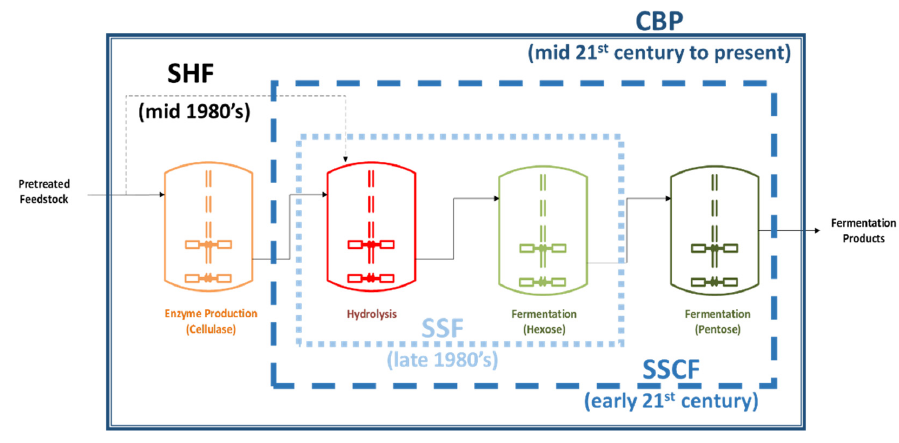
Figure 1. Schematic representation of the consolidated bioprocessing strategy.